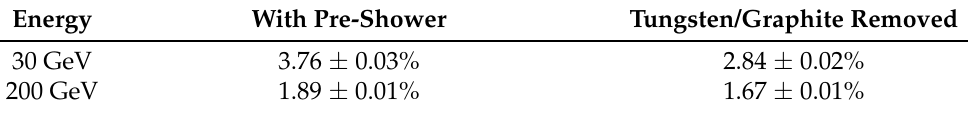
Table 2. Energy resolution measurements in test beam data at 2 different electron energies, with and without the pre-shower